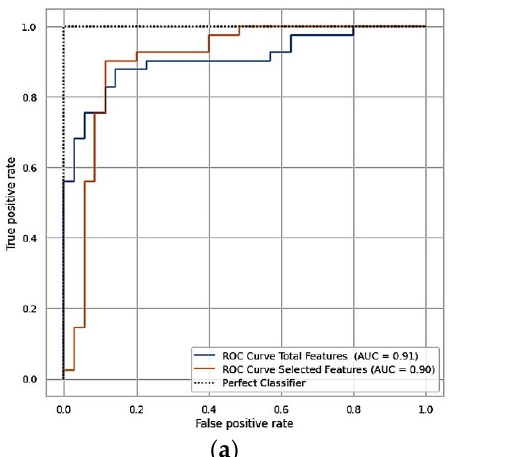
Figure 8. AUC and ROC analysis. ( a ) Cleveland dataset; ( b ) Statlog dataset.